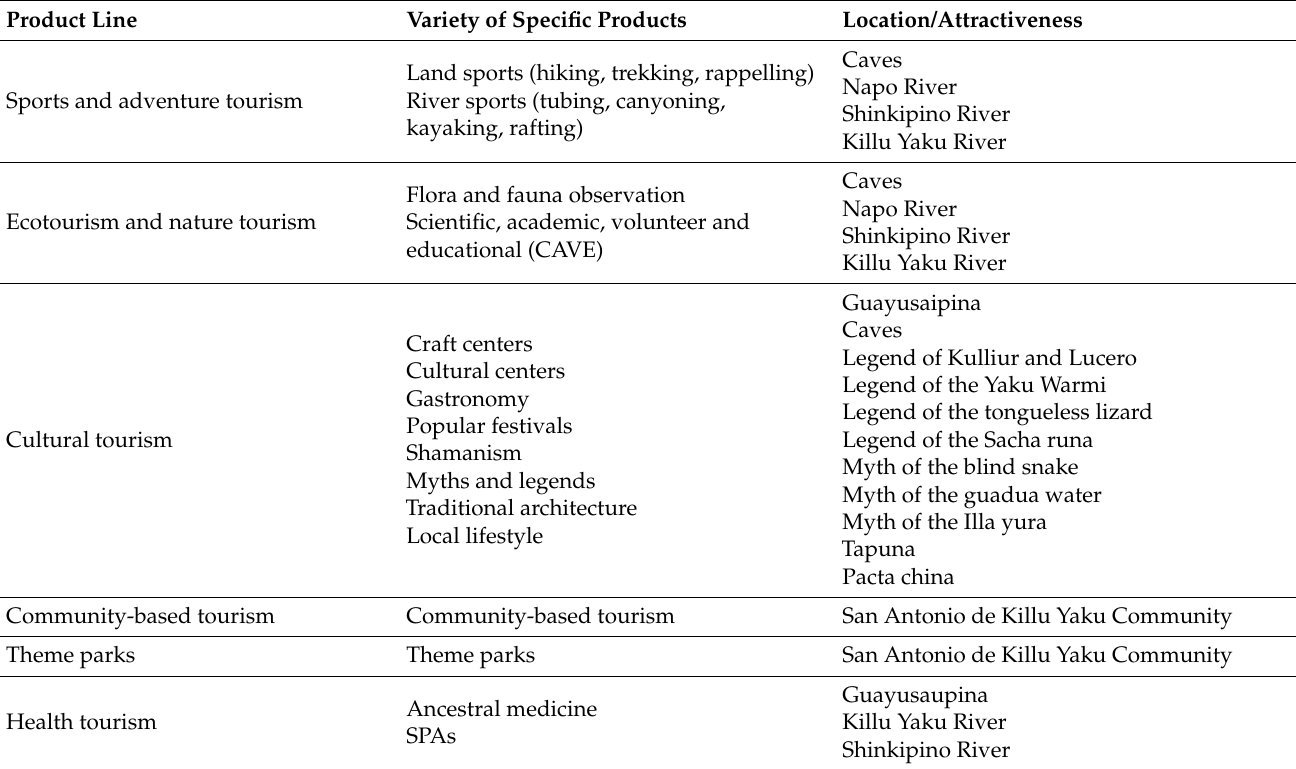
Table 1. Tourism product lines by community